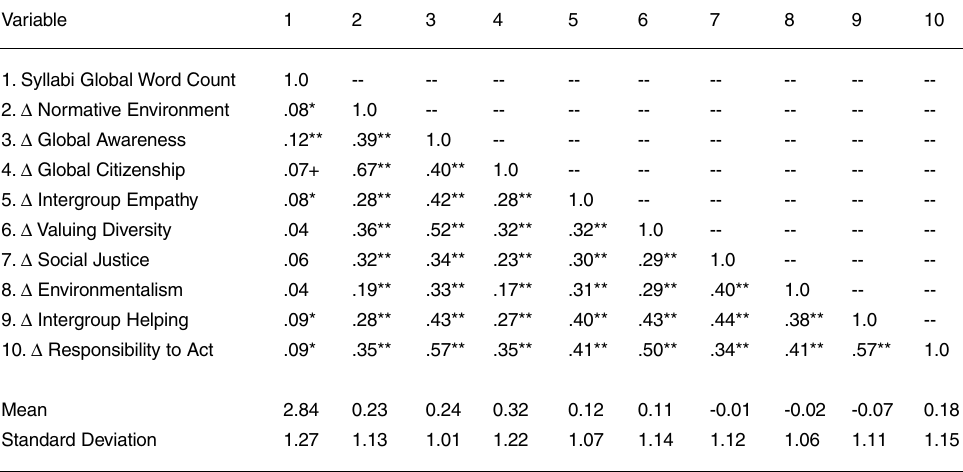
Table 1: Correlations between Syllabi Global Citizen Word Count and Antecedents, Identification, and Outcomes of Global Citizenship Change Over College